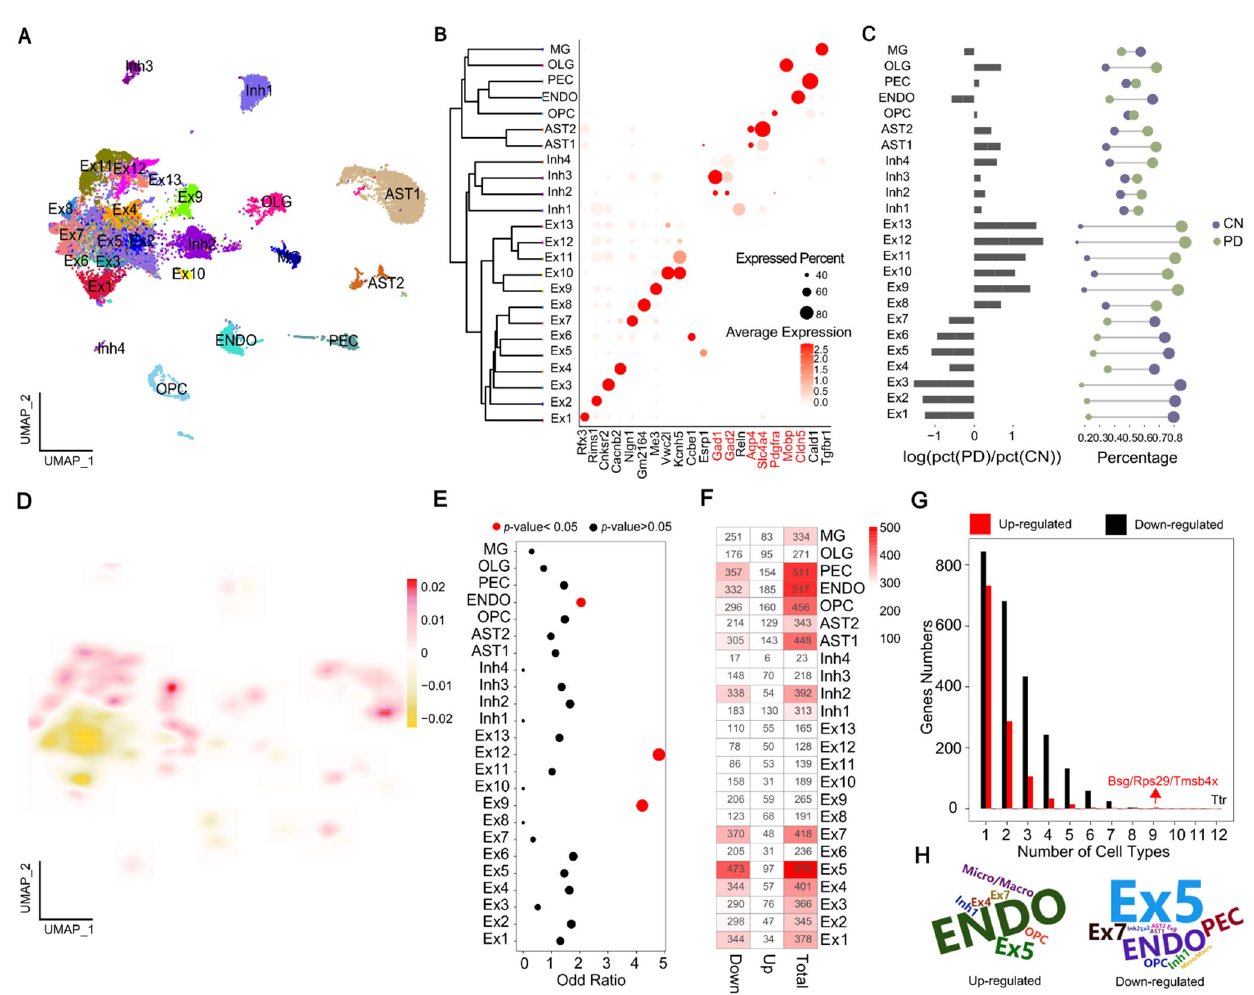
Figure 1. The characterization of cellular diversity in MPTP ‐ PD brain by snRNA ‐ seq. ( A ) Contribution of nuclei from PD or CN to each cell type; colored by cluster. ( B ) Cell representative marker genes. Expression level (color scale) of marker genes across clusters and the percentage of cell expression (dot size). ( C ) The changes in frequency of multiple cell types between PD and CN. Left: log ratio of average fraction in PD vs. CN. Right: proportion of PD and CN profiled cells. The color and dot size represent different samples and the percentage of cells, separately. ( D ) Differential 2D cell density between PD and CN. Red and yellow indicate the high and low density of cells in PD, respectively. ( E ) Using Fisher’s exact test to obtain cell types in which PD ‐ risk gene enrichment. Circle size indicates OR value, and red color highlights enriched cell types with p ‐ value < 0.05. ( F ) The number of cell ‐ specific DEGs. ( G ) The number of up ‐ or down ‐ regulated genes per cell type was detected. ( H ) PD ‐ risk DEGs’ detected frequency in each cell type.